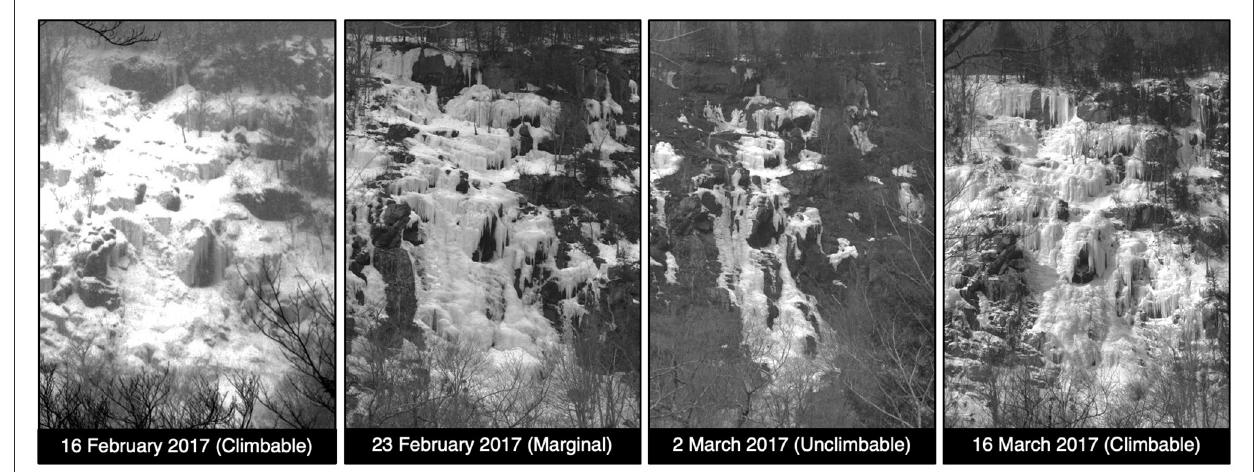
FIGURE8 Course of an icefall event during a midwinter warm up during the 2016/2017 ice season, as referred to during the focus group